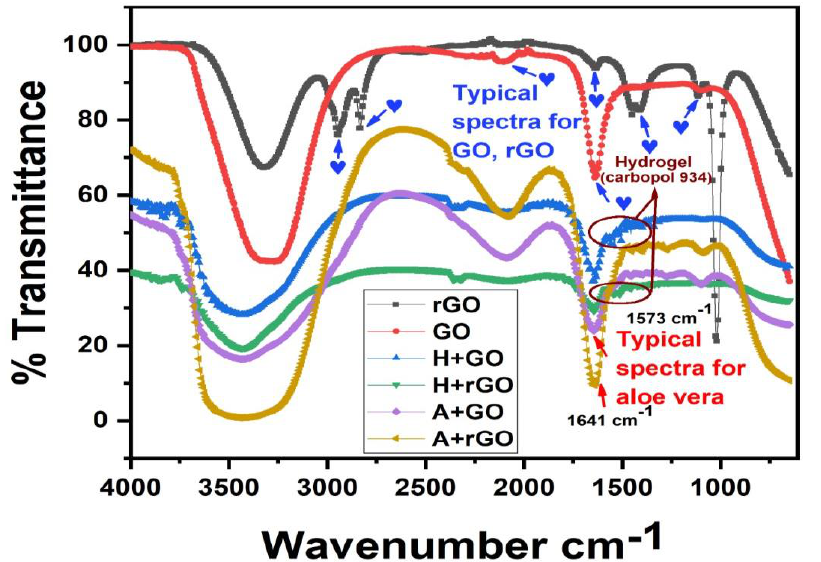
Figure 1. The FT–IR peaks of GO and rGO-based composite gels are shown. GO, which is formed as an oxidized product of graphite, contains an abundance of oxygen containing functional groups, which can be inferred from the strong intensity bands corresponding to the O–H, CH 2 , CH 3 , carboxylic, epoxy, and alkoxy C–O–C bond stretching. After the GO reduction process, the decrease in intensities or absence of oxygen-derived functional groups indicates the absence of oxygen-based functional